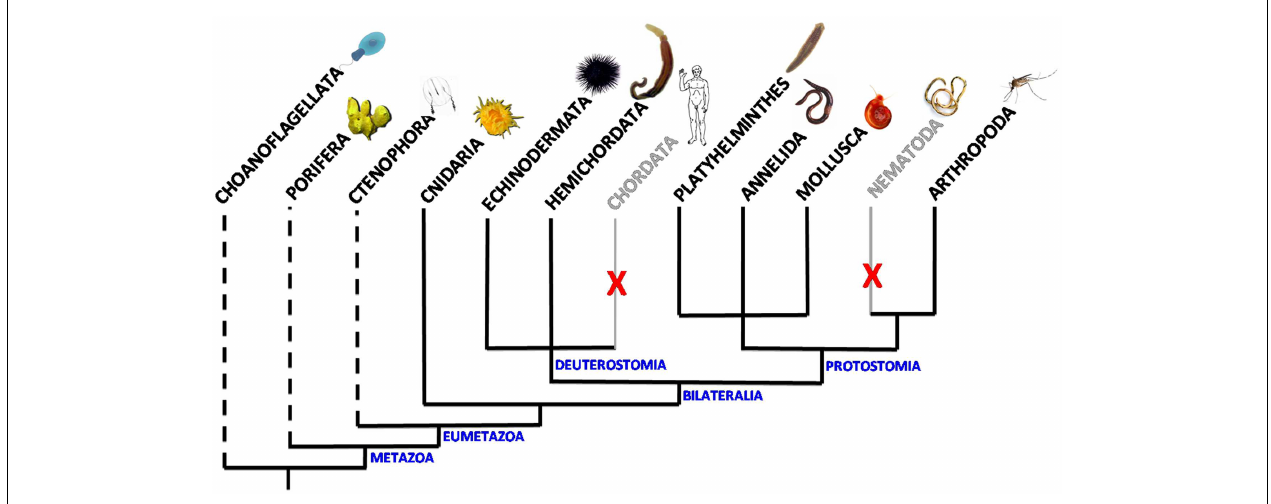
that the presence ofVKR is speculative in these phyla due to the lack of genomic data. However, putative RTKs similar toVKR have been already detected in the choanoflagellates Monosiga brevicollis (18) and Salpingoeca rosetta